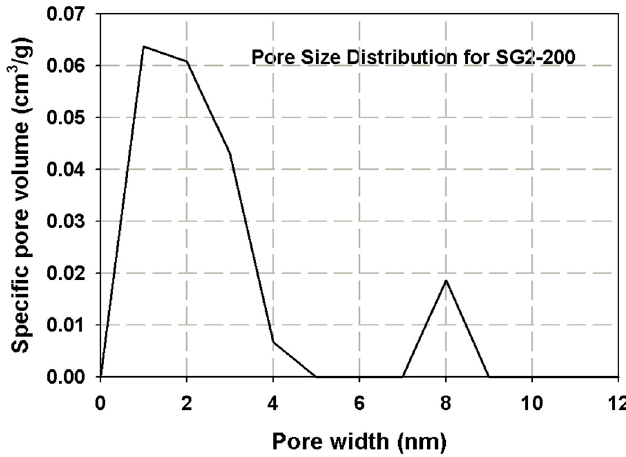
Figure 17. Calculated PSD obtained from CO 2 adsorption isotherms using GCMC simulation.